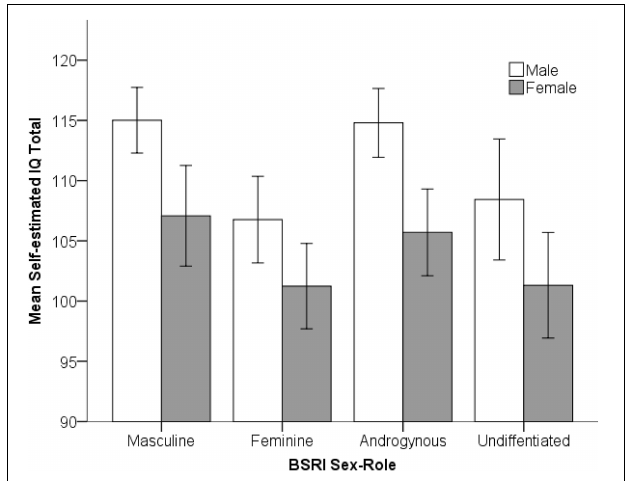
FIGURE 3 | Self-estimated IQ scores across sex-role categories, for males and females (error bars represent the standard error of the mean).